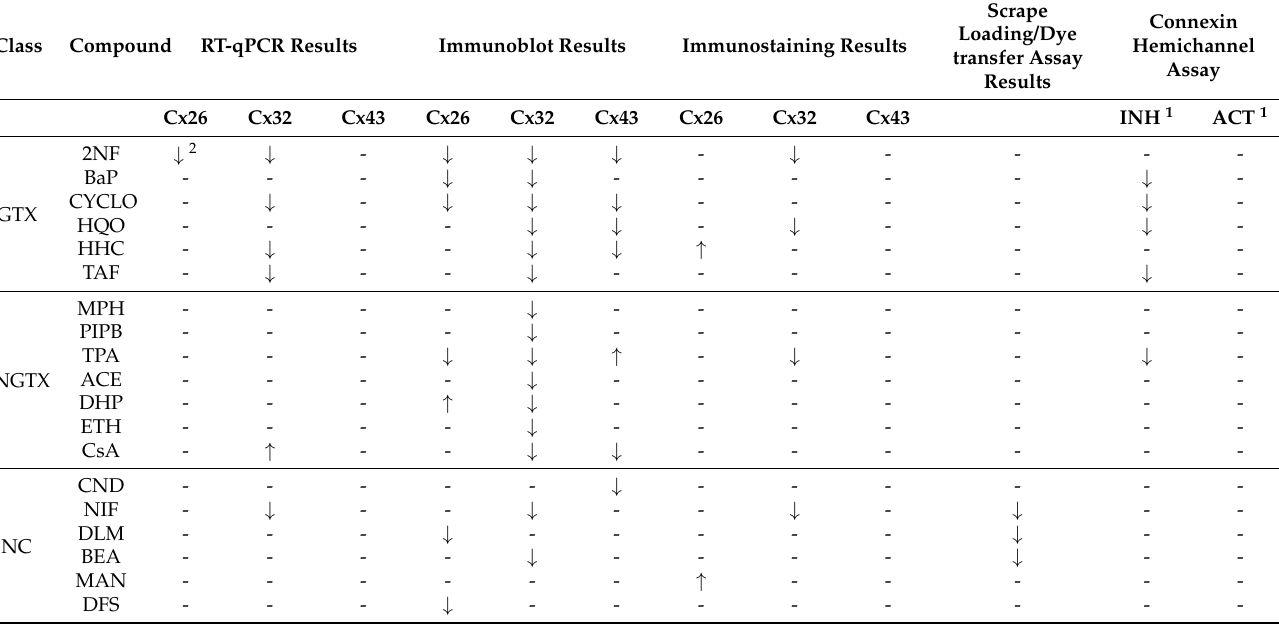
Table 2. Effects of GTX, NGTX, and NC chemicals on connexin expression and functionality in human hepatoma HepaRG cells.